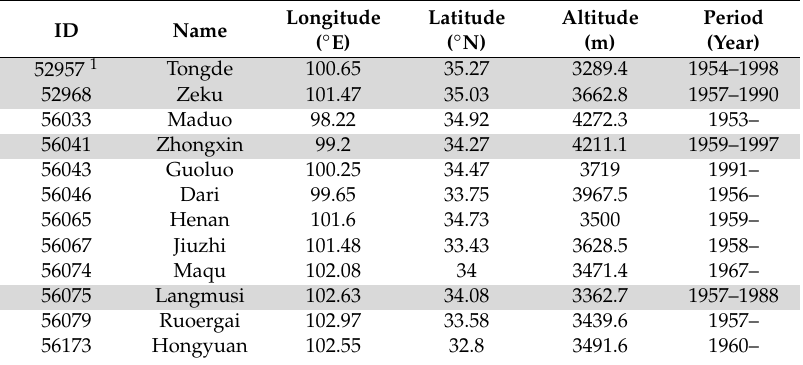
1 gray shaded represents an historical national station.